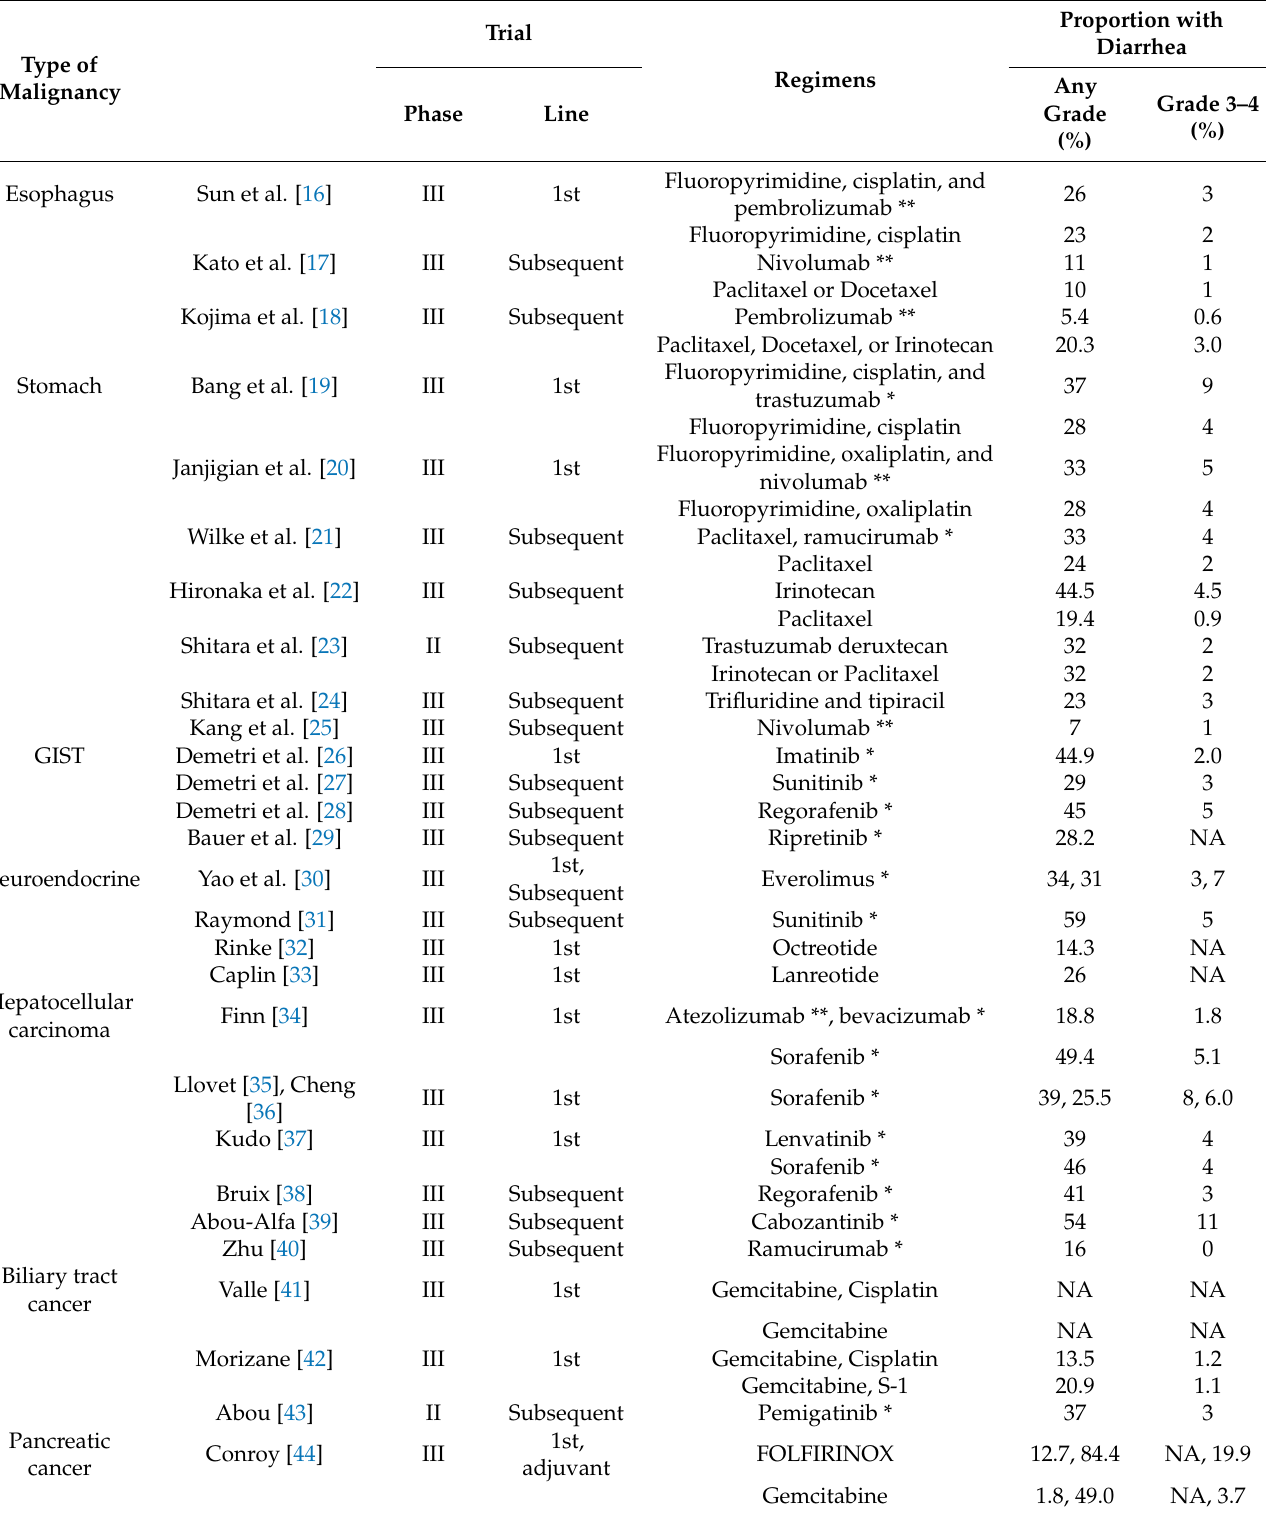
Table 2. Pivotal clinical trial data of frequency of diarrhea in systemic chemotherapy for gastrointesti- nal